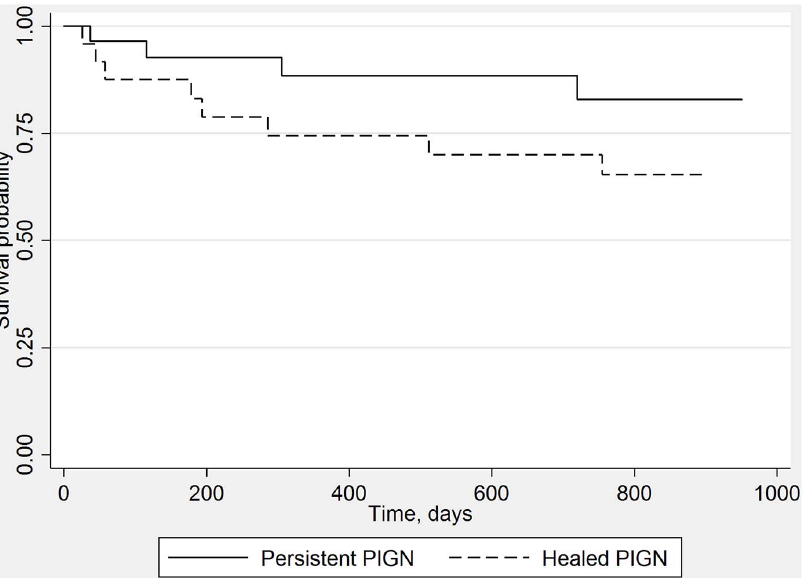
Figure 2. Mortality according to histopathological pattern of PIGN: Patients with healed PIGN had significantly worse survival compared to those of persistent PIGN, log-rank test.